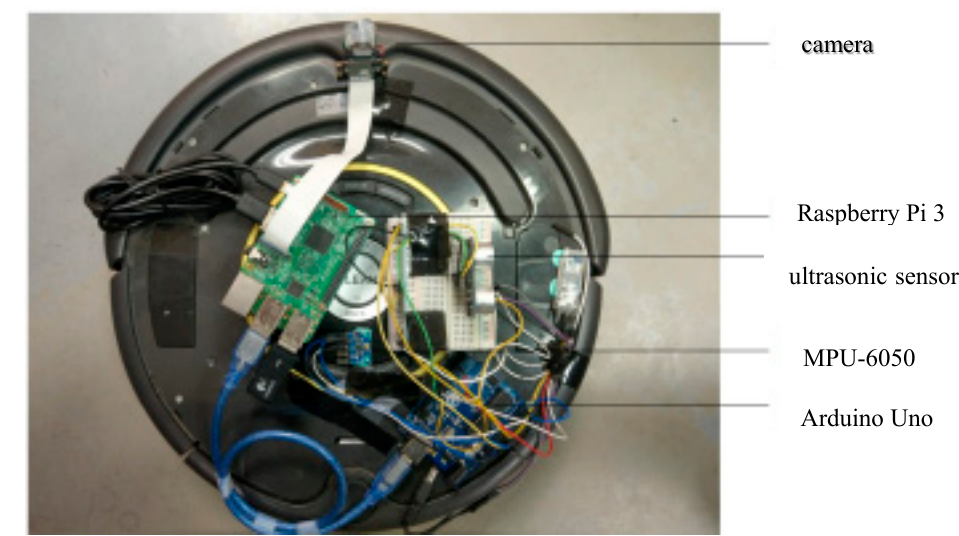
Figure 2. Cleaning robot hardware architecture.